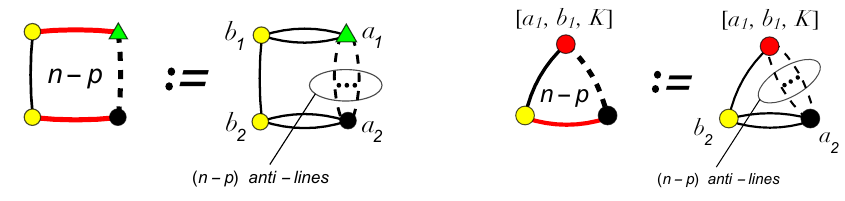
Figure 3 . Loop box and triangle